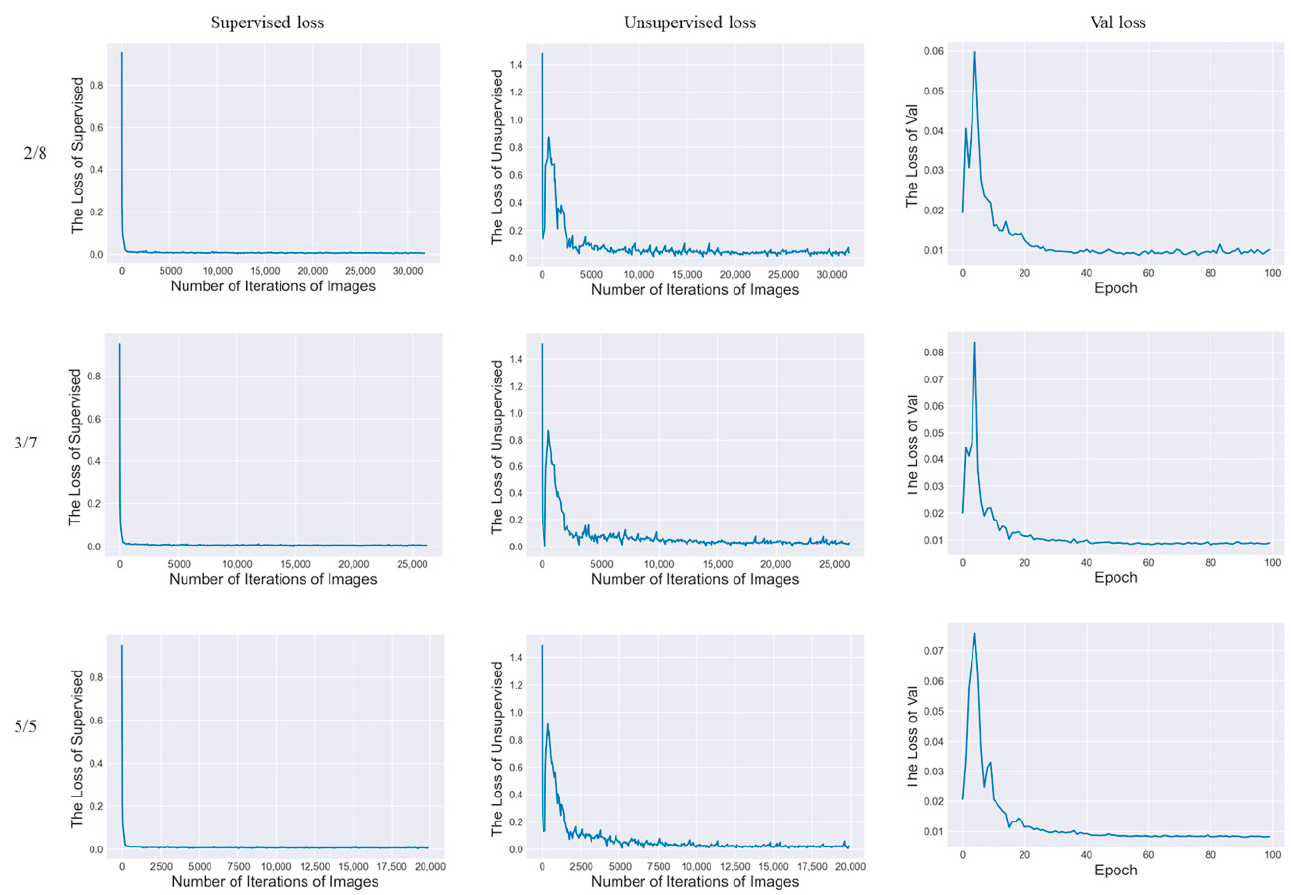
Figure 13. Loss curve for supervise training loss, unsupervised training loss and validation loss on the Flame dataset.